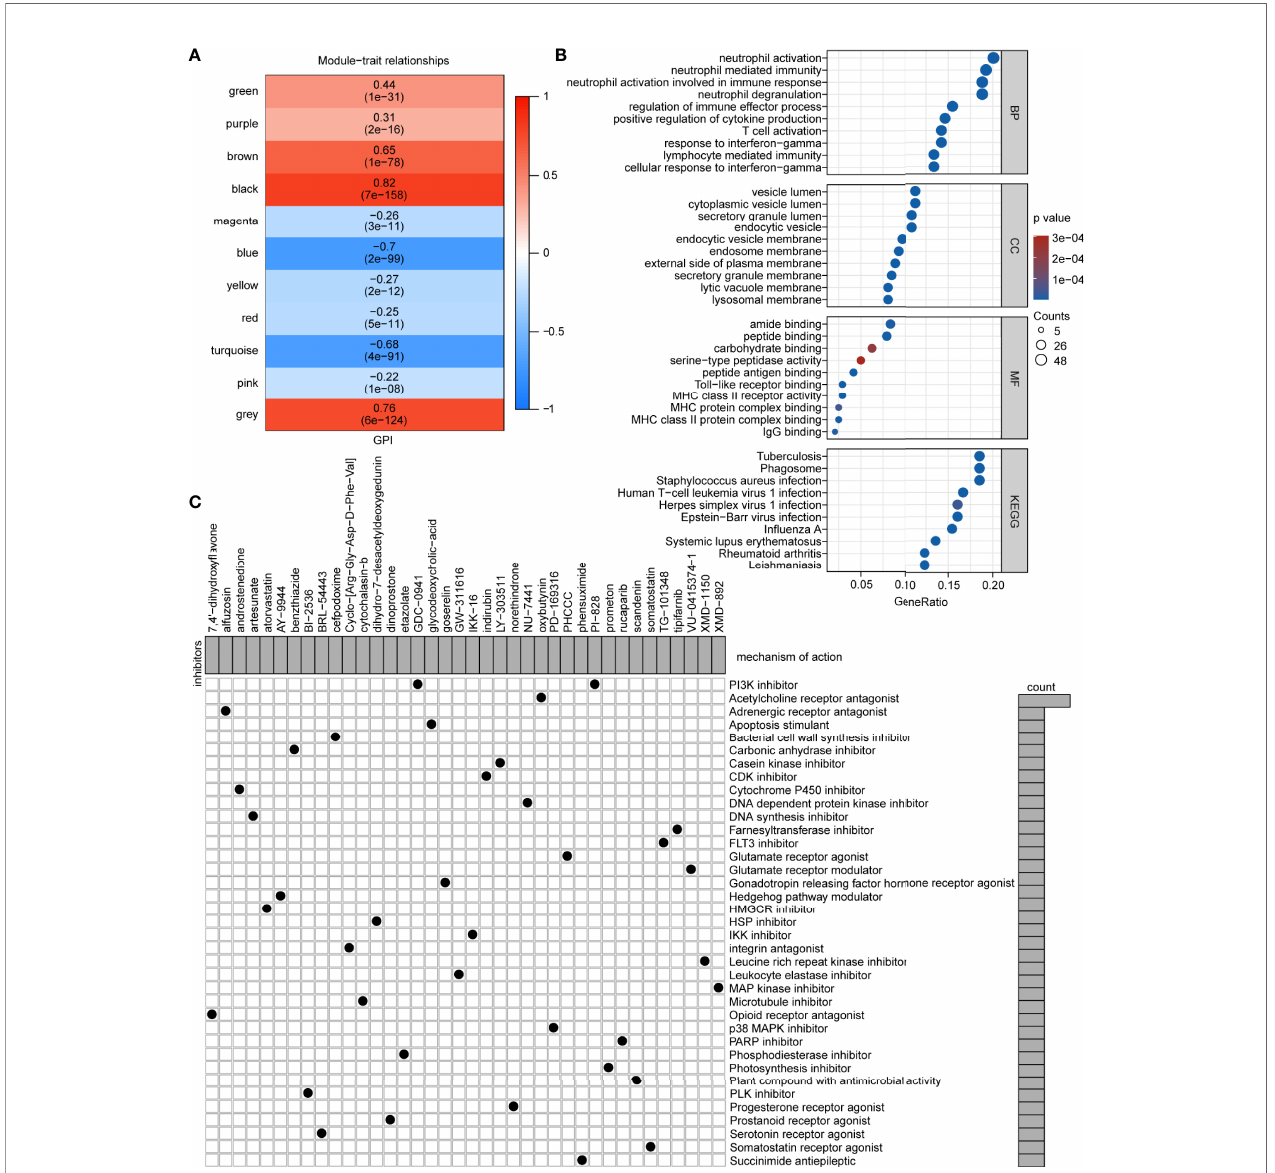
FIGURE 10 | Potential small-molecule compounds based on GPI. (A) Module-trait relationships from the WGCNA. (B) Bubble map of GO functional and KEGG pathway enrichment analyses. BP, biological process; CC, cellular component; MF, molecular function. (C) MOA analysis results using the CMap database showing small-molecule compounds with corresponding mechanisms of